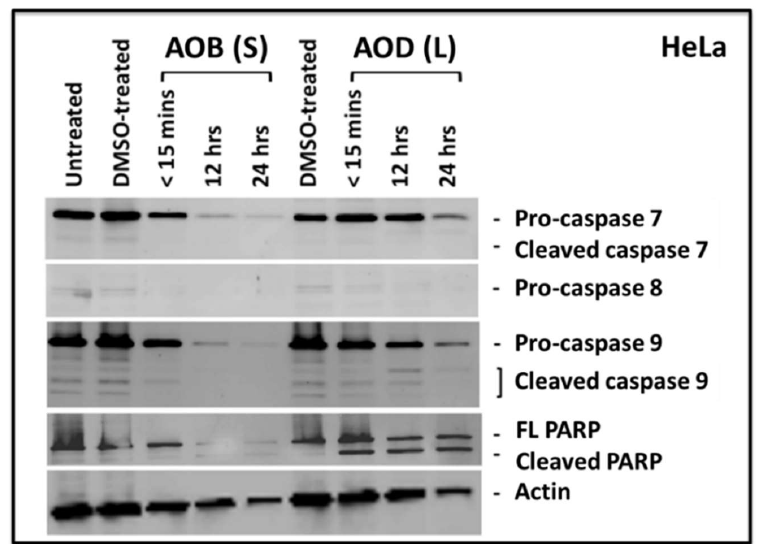
Figure 5. Western blot analysis of MCF-7 cells treated with A. orientalis dichloromethane leaf fraction (AOD (L)) at 250 µg/mL and tested for the activation of caspases 7, 8 and 9, and poly ADB ribose polymerase (PARP). Actin antibody was used as a loading control. DMSO-treated, DMSO control having the same amount of DMSO as the test sample.